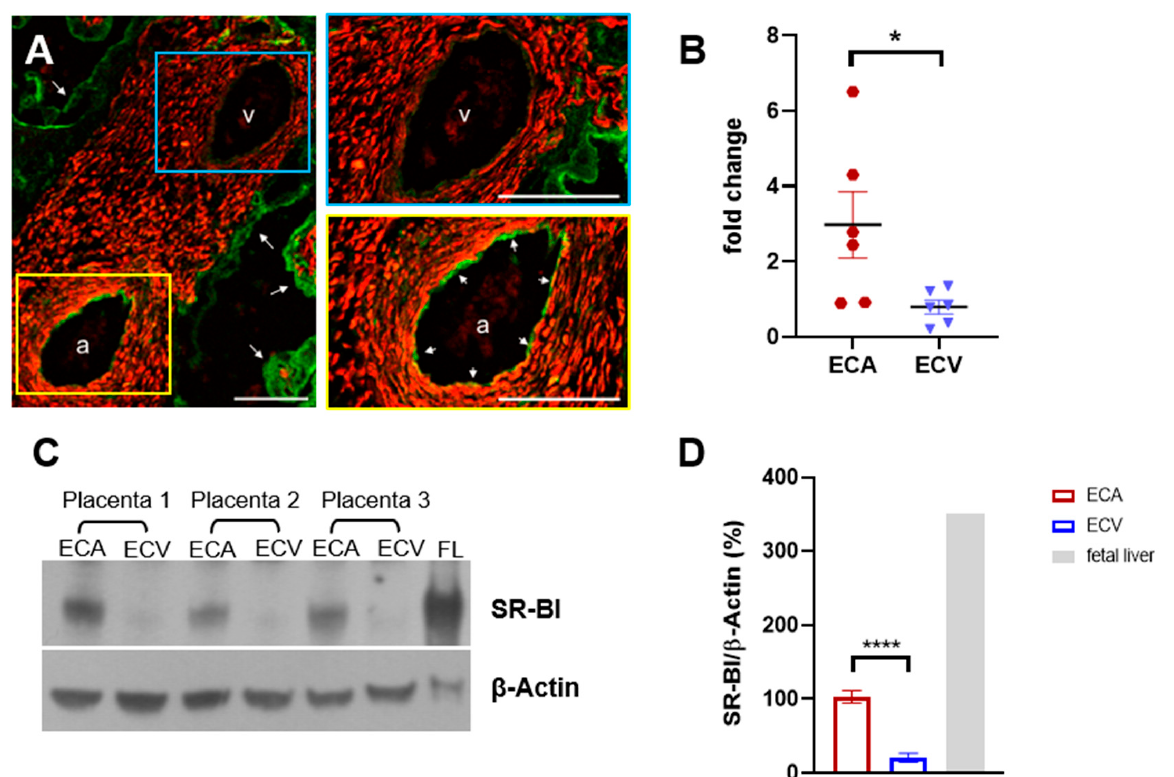
Figure 1. ( A ) Immune fluorescence staining against SR-BI in a term placental stem villus. SR-BI (green) was found on the syncytiotrophoblast (white arrows, overview picture) and on the endothelium of villous arteries (yellow framed detail picture) but not on the endothelium of villous veins (blue framed detail picture). Placental tissue was double-stained against Desmin (red) to visualize villous structures. Scale bars: 80 µ m. ( B ) qRT-PCR demonstrated higher SR-BI mRNA expression in ECA compared to ECV ( n = 6 each, mean ± SD, t -test). ( C ) Representative Western Blot of SR-BI protein in ECA and ECV from three different placentae. β -Actin was used as the loading control. ( D ) Densitometric quantification of SR-BI relative to β -Actin as detected by Western Blot in paired ECA and ECV ( n = 6), fetal liver served as a positive control for SR-BI detection. ECA showed higher SR-BI protein abundance compared to their respective venous counterparts (mean ± SD, one-way ANOVA), * p < 0.05, **** p <